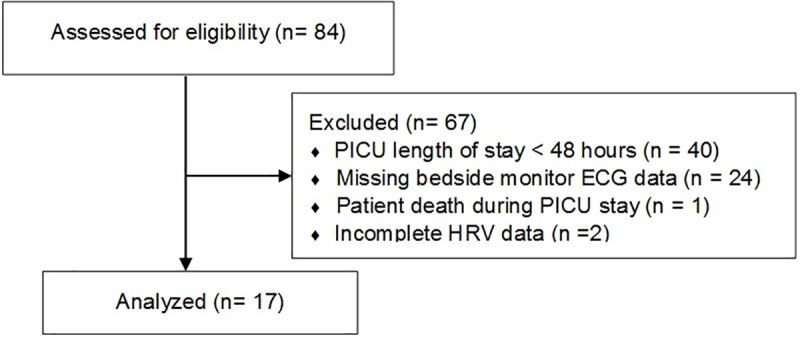
Cohort inclusion and exclusion flow diagram.